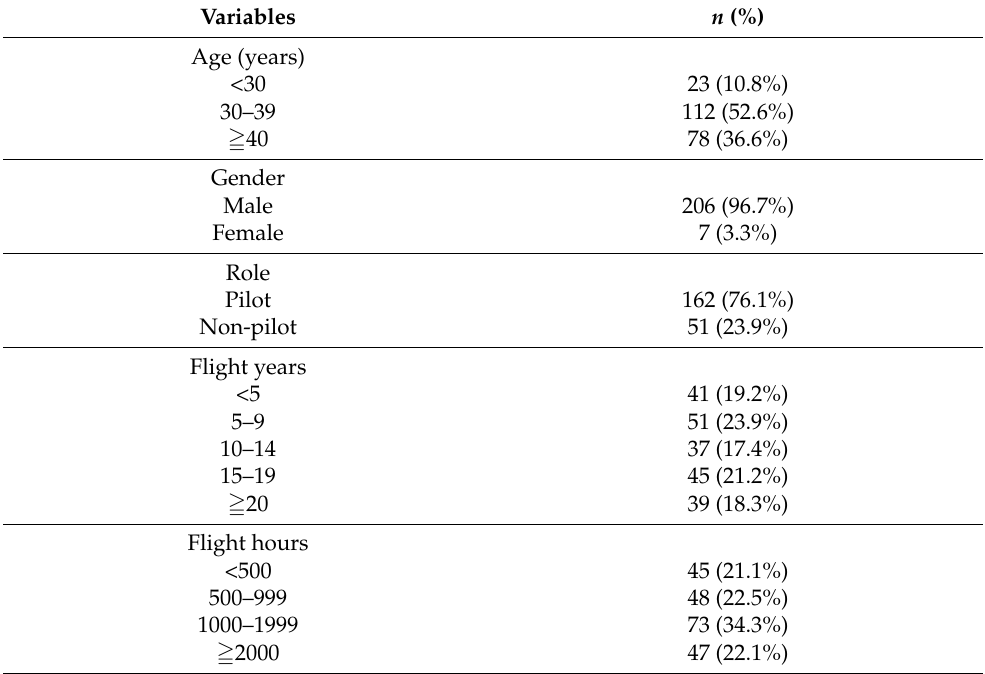
Table 1. Demographic data of study subjects.